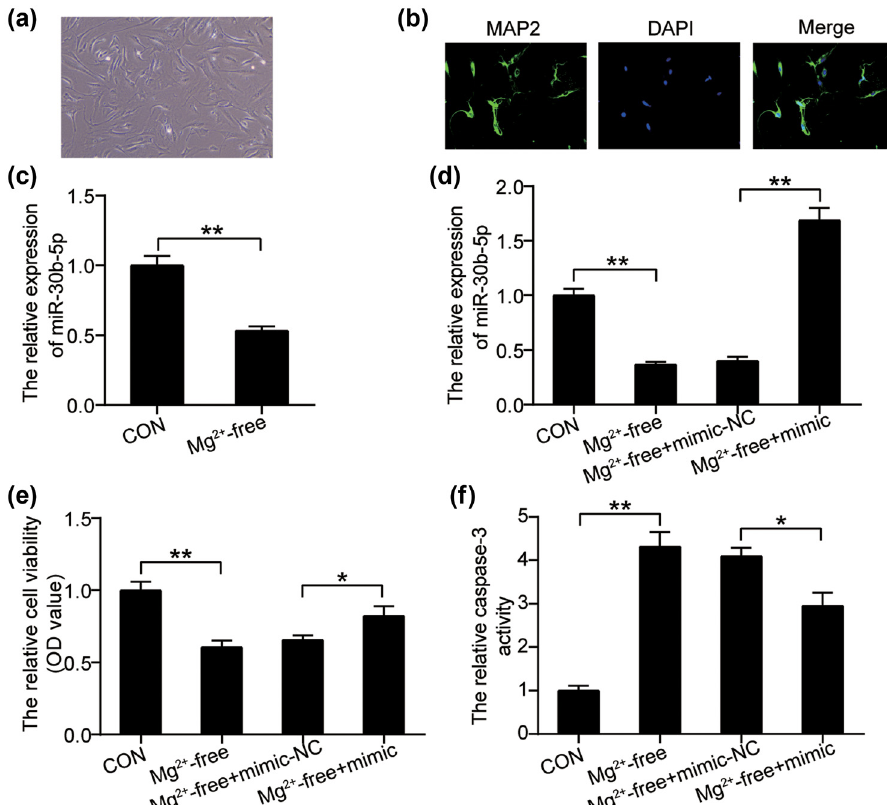
Figure 2: miR - 30b - 5p overexpression abrogates the inhibitory e ff ect exerted by magnesium - free condition on hippocampal neurons pro - liferation. ( a ) E ffi cacy of isolation was observed by a light microscope at 200 × magni fi cation. ( b ) E ffi ciency of isolation was detected using immuno fl uorescence staining. The green fl uorescence indicates MAP2, and the blue fl uorescence indicates nuclear staining ( DAPI ) . ( c ) RT - qPCR analysis of miR - 30b - 5p in hippocampal neurons in the presence or absence of free magnesium. ( d ) RT - qPCR analysis of miR - 30b - 5p in hippocampal neurons transfected with miR - 30b - 5p mimic or mimic NC in the presence or absence of free magnesium. ( e ) CCK8 assays determining the cell proliferation in hippocampal neurons transfected with miR - 30b - 5p mimic or mimic NC in the presence or absence of free magnesium. ( f ) Caspase - 3 activity assessment in hippocampal neurons transfected with miR - 30b - 5p mimic or mimic NC in the presence or absence of free magnesium. * P < 0.05, ** P < 0.001. NC, negative